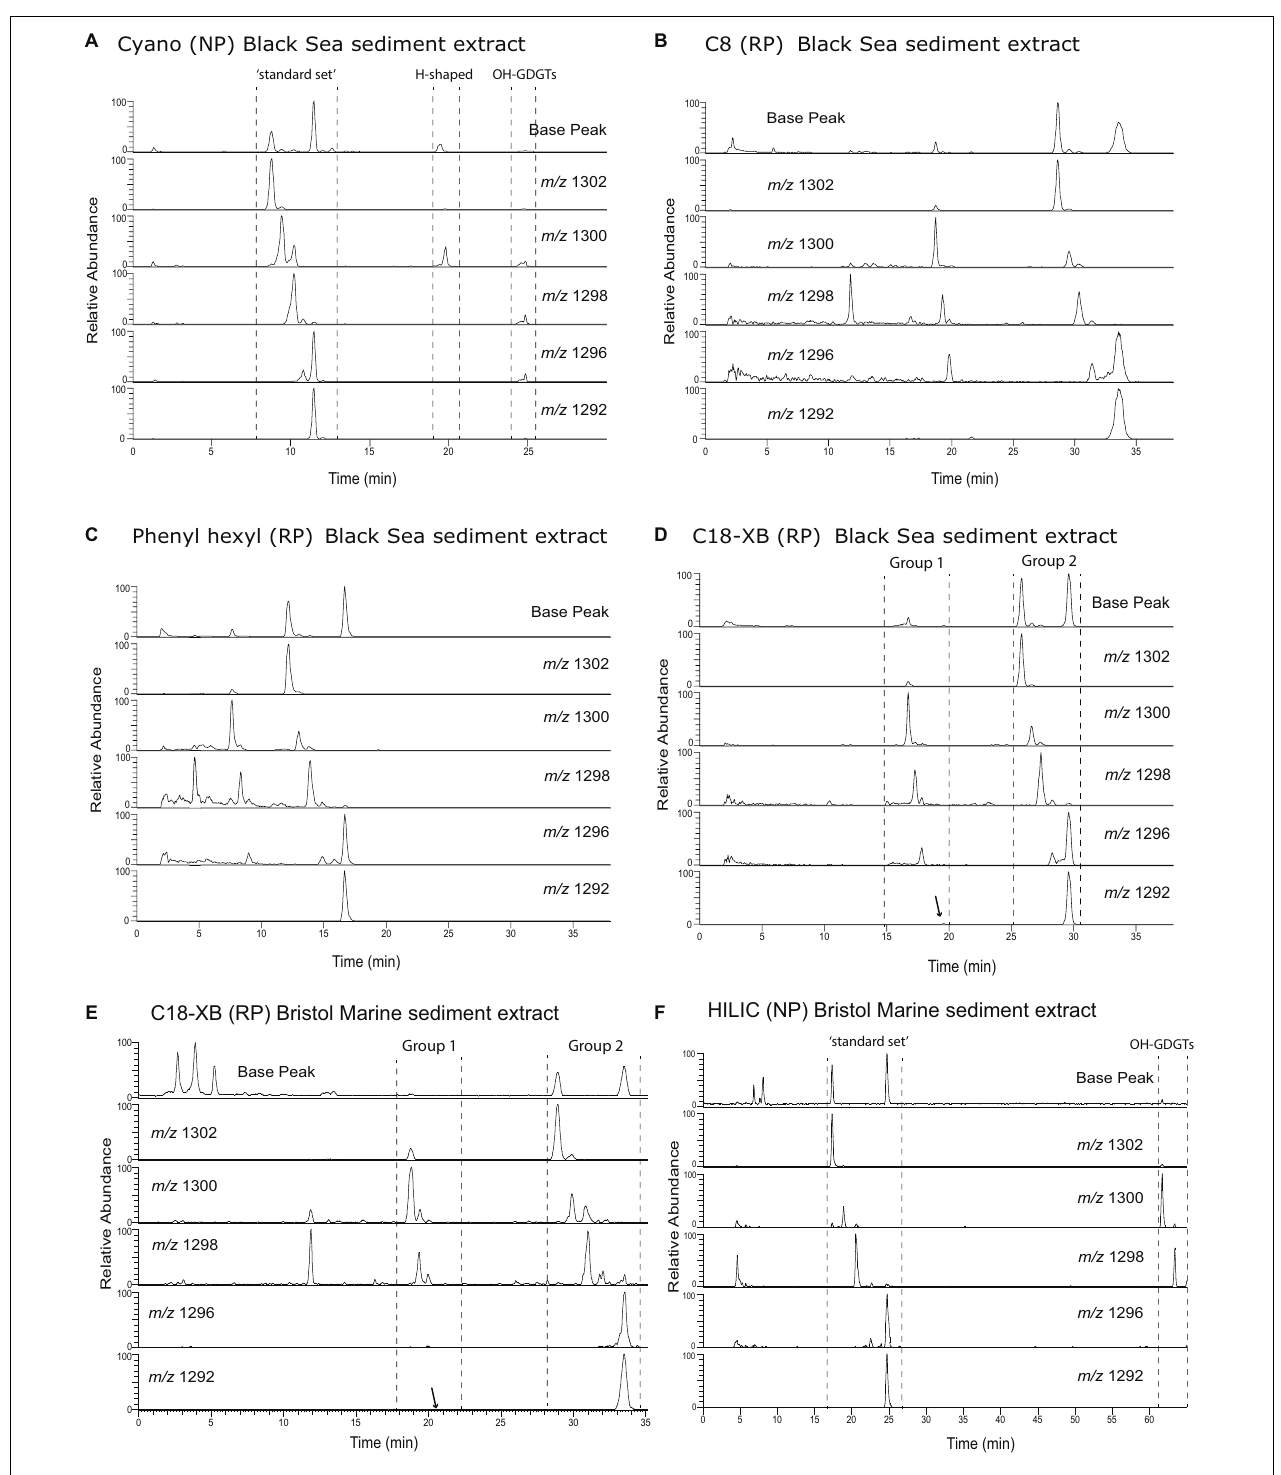
FIGURE 2 | Base peak and selected ion monitoring chromatogram of isoprenoid GDGTs from two marine sediment extracts. The Black Sea extract was analyzed using (A) Cyano column, NP; (B) C8, RP; (C) phenyl hexyl, RP; (D) C18-XB, RP columns. Due to a lack of sample material a Bristol marine sediment extract analyzed using (E) C18-XB and (F) HILIC is also shown. Indicated OH-GDGTs are identified using a combination of an RP fractionation experiment (described in section “Isoprenoid GDGTs in Marine Sediment”), RP and NP retention times found in the literature (see text). For RP, two clear groups can be identified. Note the small peak in the 1292 isomer is indicated by an arrow at 20 min in (D,E) . Supplementary Figure S6A compares the chromatography of C18-XB and HILIC using the British peat